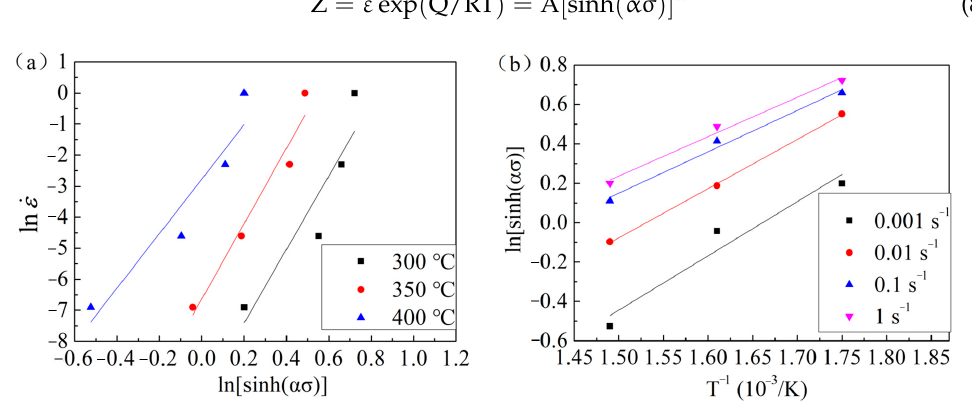
Figure 7. Linear relationship fitting: ( a ) lnε(cid:4662) − ln(cid:4670)sinh(cid:4666)ασ)(cid:4671) ( b ) ln(cid:4670)sinh(cid:4666)ασ)(cid:4671) − 1/T . The Z parameter’s physical meaning is the factor of strain rate used for temperature compensation. Logarithm was taken on both sides of Equation (9), and thus obtained: Based on Equation (9), the ln Z − ln [ sinh ( ασ )] linear regression data were obtained at n = 10.602, lnA = 35.145, respectively, as depicted in Figure 8. Thus, the value of A is 1.833 × 10 15 s − 1 . According to the Arrhenius function definition, σ can be represented as a function of the Z parameter as indicated in Equation (10).